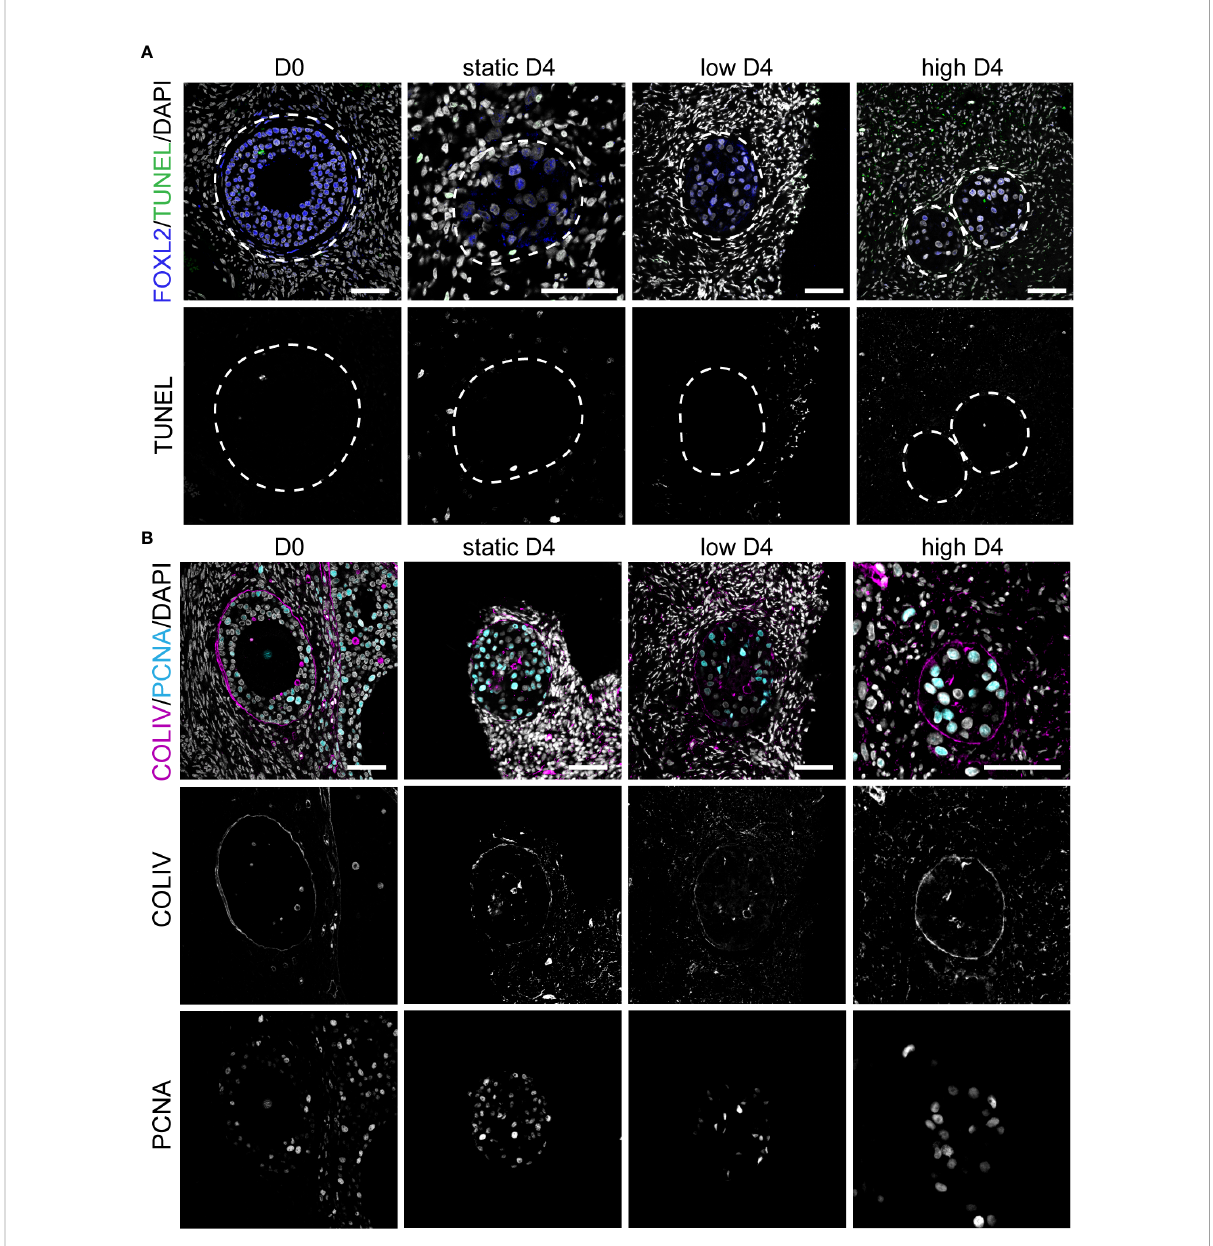
FIGURE 5 Apoptosis, proliferation and COLIV deposition in ovarian cortical cubes after four days of culture. (A) Immuno fl uorescence for FOXL2 together with TUNEL assay in secondary follicles at D0 and after four days (D4) culture in static, low and high fl ow rate. Scale bars= 50 m m. (B) Immuno fl uorescence for COLIV and PCNA in secondary follicles at D0 and after D4 culture in static, low and high fl ow rate. Scale bars= 50 m